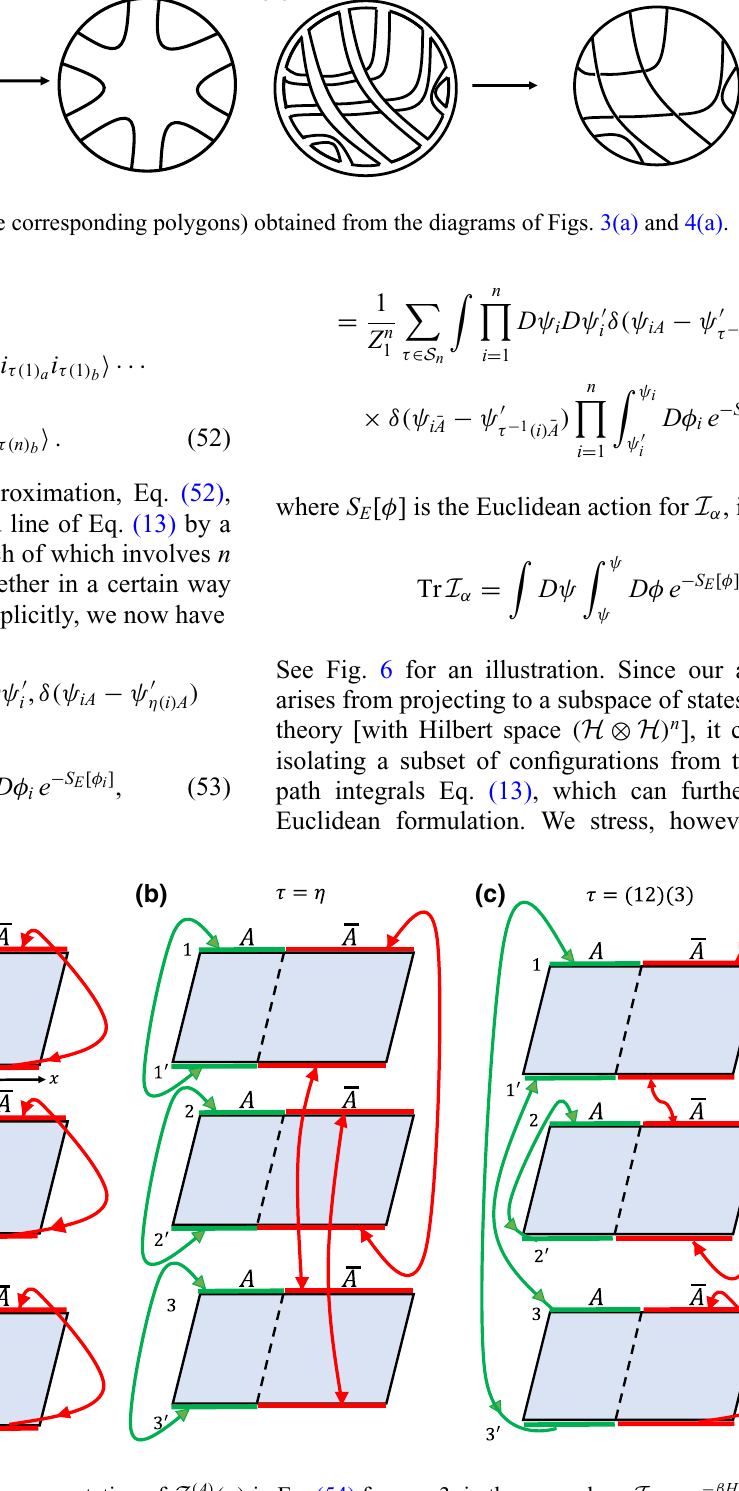
(τ) in Eq. (54) for n = 3, in the case where I = e − β H and the system FIG. 6. Examples of the path-integral representation of Z ( A ) α n is (1+1) dimensional. In the i th replica, the final state is labeled by ψ i (which we indicate by 1, 2, 3 in the figure) while the initial state (which is indicated by 1 (cid:8) , 2 (cid:8) , 3 (cid:8) ). The shaded regions represent Euclidean path integrals from t (cid:8) = 0 to t (cid:8) = β between is labeled by ψ (cid:8) i , while the final states ψ are the initial and final states. For each τ , the final states ψ iA are identified with the initial states ψ (cid:8) i ¯ A τ − 1 η( i ) A , as indicated with the arrows in each identified with the initial states ψ (cid:8) τ − 1 ( i ) ¯ A